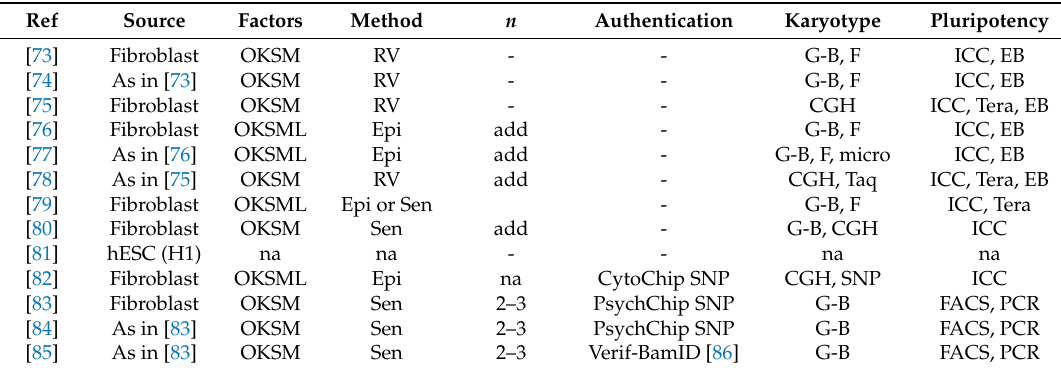
Table 2. iPSC generation and quality